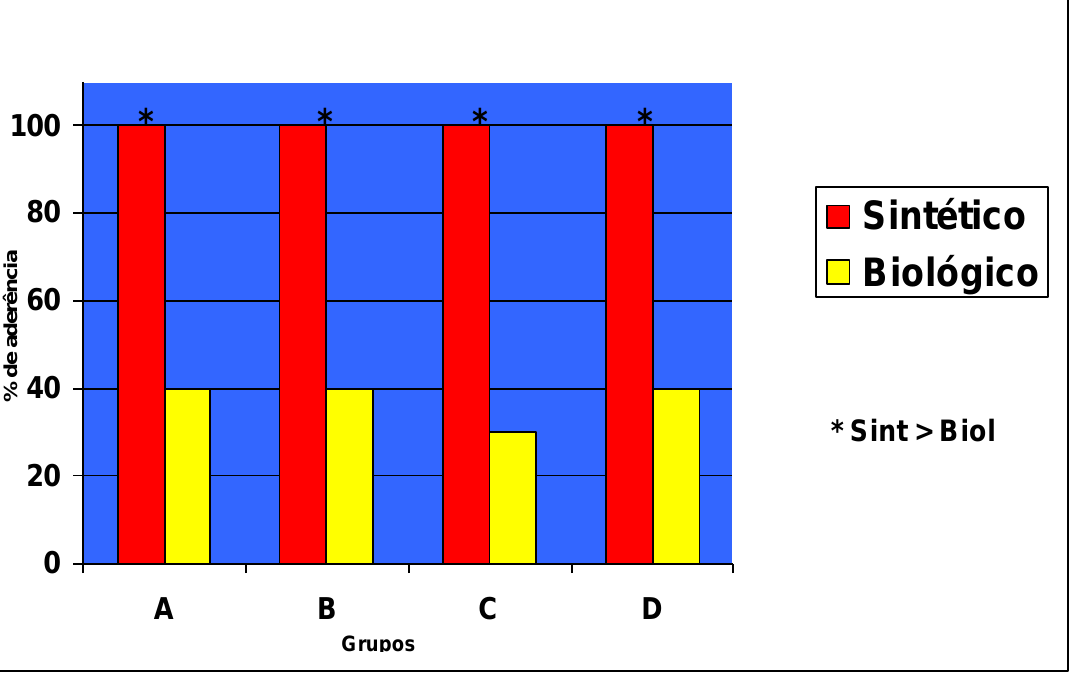
FIGURA 1 – Distribuição das percentagens da presença ou ausência de aderência da anastomose jejuno-jejunal após síntese com adesivo sintético ou biológico entre dois (GA), quatro (GB), seis (GC) e oito (GD) pontos aos 14 dias de